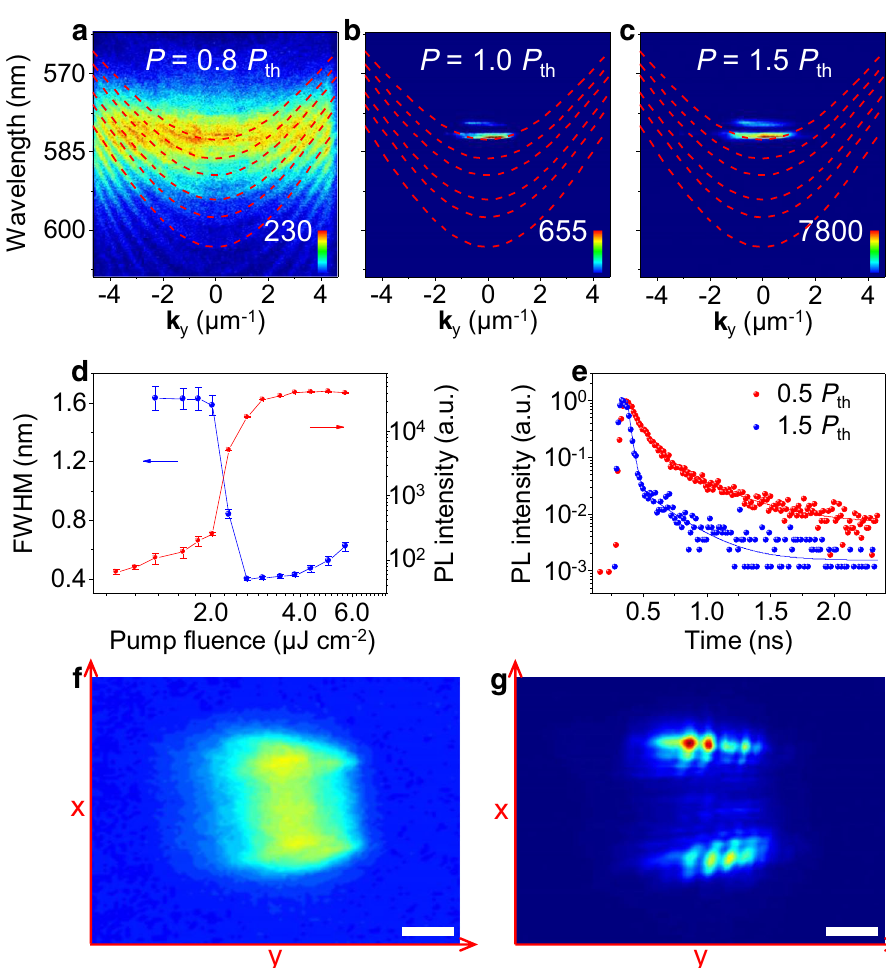
Fig. 3 Polariton condensation in the PDI-O microribbon. a – c AR μ -PL spectra of the PDI-O microribbon measured at 0.8 P th , 1.0 P th , and 1.5 P th , respectively. Dashed curves are fi tted polariton dispersion. When the pump fl uence reaches a threshold, the polariton emission collapses to the bottom of the polariton dispersion with a sharp increase of intensity, suggesting the onset of polariton condensation. The microribbon was pumped by a pulsed laser (400 nm, 150 fs, 1 kHz). d Emission intensity and FWHM at k y = 0 ( θ = 0) as a function of pump fl uence. The PL intensity was plotted on a log – log scale. Error bars indicate the 95% con fi dence intervals obtained from the fi ts to the measured PL spectra. e The time-resolved PL decay pro fi les at 0.5 P th (red) and 1.5 P th (blue). The lifetimes below and above P th are 277 and 47 ps, respectively. f The image of the interference pattern in Young ’ s double-slit interferometry experiment below the threshold. g The image of the same microribbon recorded above the threshold. Scale bars are 8 μ m. The x - and y -direction in f and g correspond to the direction of the microribbon width and length,